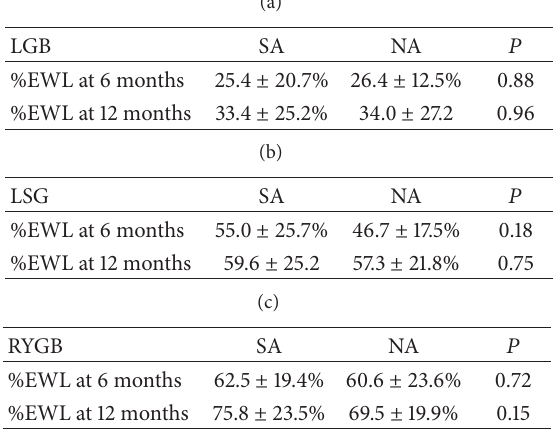
Table 2: Weight loss comparison between patients with prior sub- stance abuse and those without prior substance abuse in three different bariatric